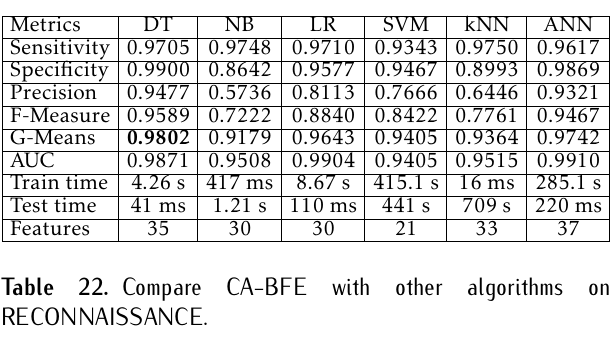
Table 21. Results of using CA-BFE on RECONNAISSANCE.